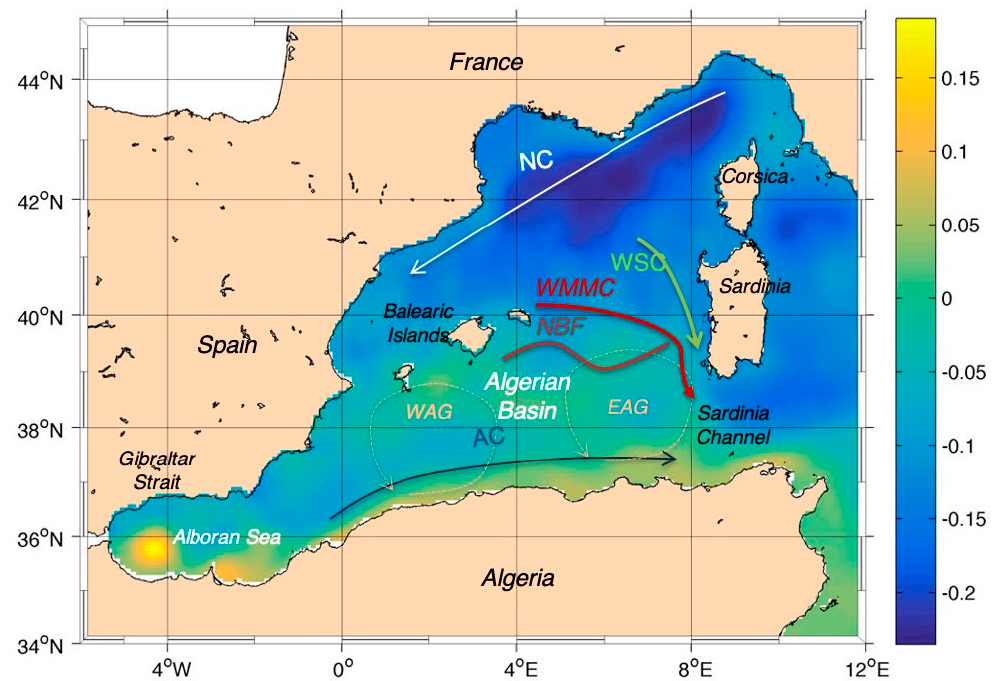
Figure 1. Mean dynamic topography (MDT) of the Western Mediterranean Sea map of the study area (adapted from [7]). Northern Current (NC), Algerian Current (AC), Western Sardinia Current (WSC), Western Mid-Mediterranean Current (WMMC), North Balearic Front (NBF) and mean position of Western Algerian gyre (WAG) and Eastern Algerian gyre (EAG) are labeled. Color scale showing MDT values [m].